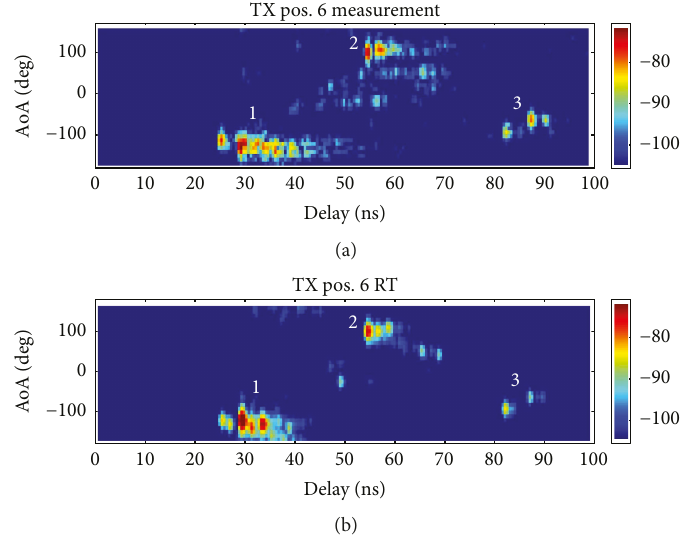
Figure 11: Measured (a) and RT-simulated (b) power-angle-delay pro fi les for Tx position 6 in the basement scenario. Note that all identi fi ed multipath components are present within the 100 ns delay range in the non-LOS region.